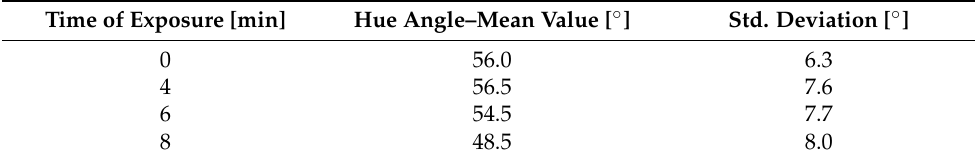
Table 1. Descriptive statistics of skin color in regards to the duration of UV exposure (N = 38). Time of Exposure [min]